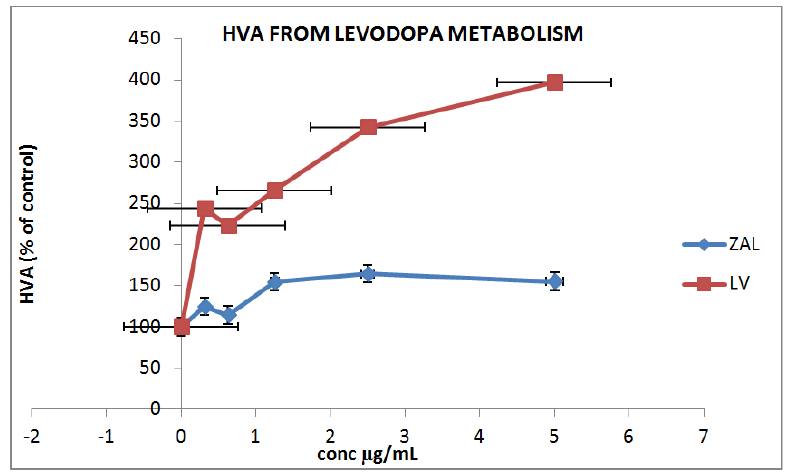
Figure 6. Dopamine metabolite (HVA) release from pure levodopa (LV) and levodopa intercalated in zinc aluminum nano delivery system (ZAL). There is a statistically significant difference between the three groups, p < 0.01 ( i.e. , Control, ZAL and LV) as tested by one-way ANOVA. A further test using Dunett’s post-hoc test shows a significant difference between ZAL and LV, also between LV and control, but not between ZAL and